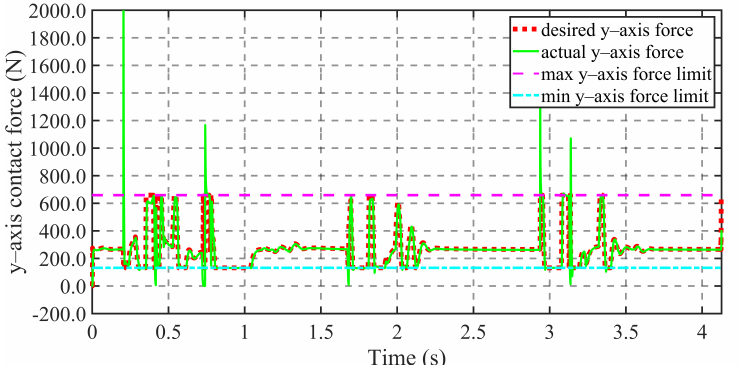
Figure 11. Vertical contact force when the robot slides on uneven